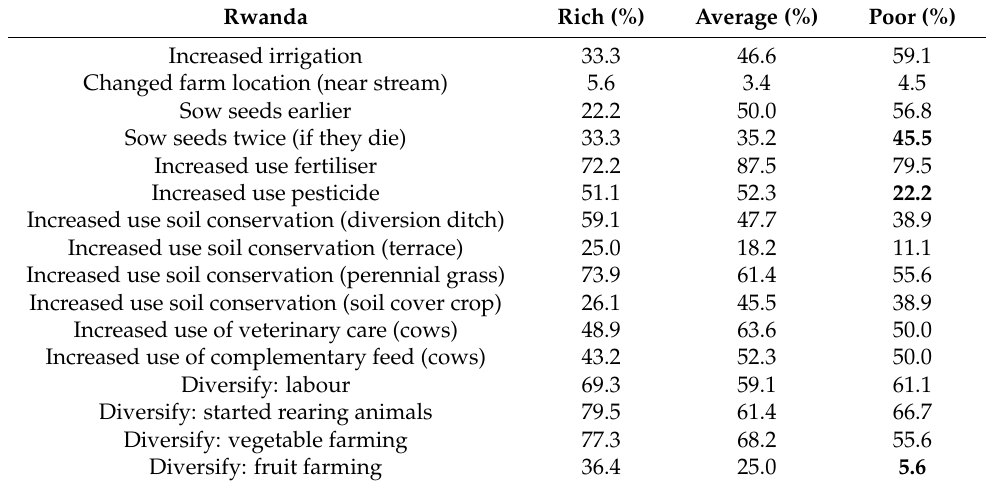
Table 3. Differential adaptation responses by wealth groups by farmers around Nyungwe, Rwanda (n = 150). % refers to the % of respondents within each wealth group. Bold referes to Significant differences across wealth groups at p < 0.05, using cross-tabulation tables and chi-square